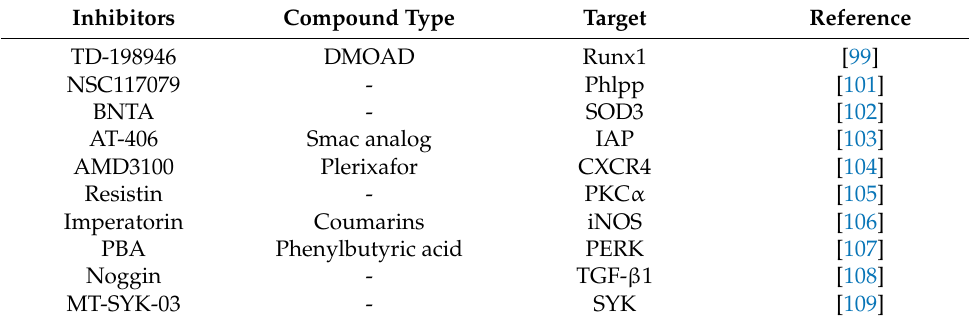
Table 5. Small molecule inhibitors targeting other